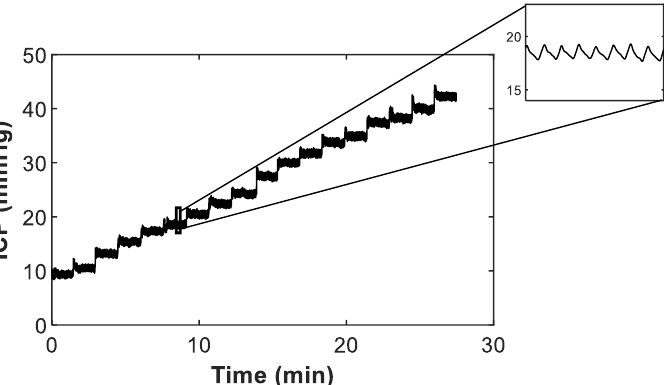
Figure 3. Stepwise increases in intracranial pressure (ICP) measured inside the intracranial chamber. The zoom-in part at the top right shows the in vitro modelling of the cardio-synchronous vasogenic arterial pulsations normally observed in the ICP waveform measured in humans.